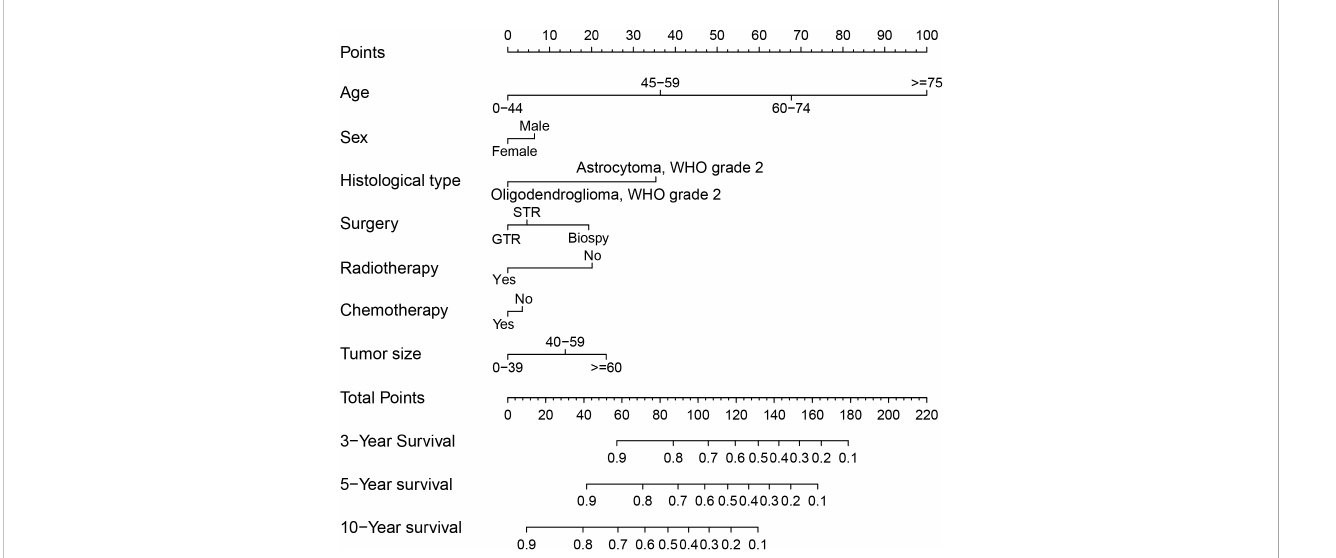
FIGURE 2 Nomogram for prognostication of patients with DLGGs. Independent prognostic factors included age (P<0.001) , sex (P<0.05) , histological type (P<0.001) , surgery (P<0.001) , radiotherapy (P<0.001) , chemotherapy (P<0.05) , and tumor size (P<0.001) . A vertical line is drawn upward, and the intersection with the point-line is the score for each variable. We calculated the total score for each patient and predicted 3-year, 5-year, and 10-year OS. “ STR ” , “ subtotal resection of tumor ” ; “ GTR ” , “ gross total resection of tumor ”